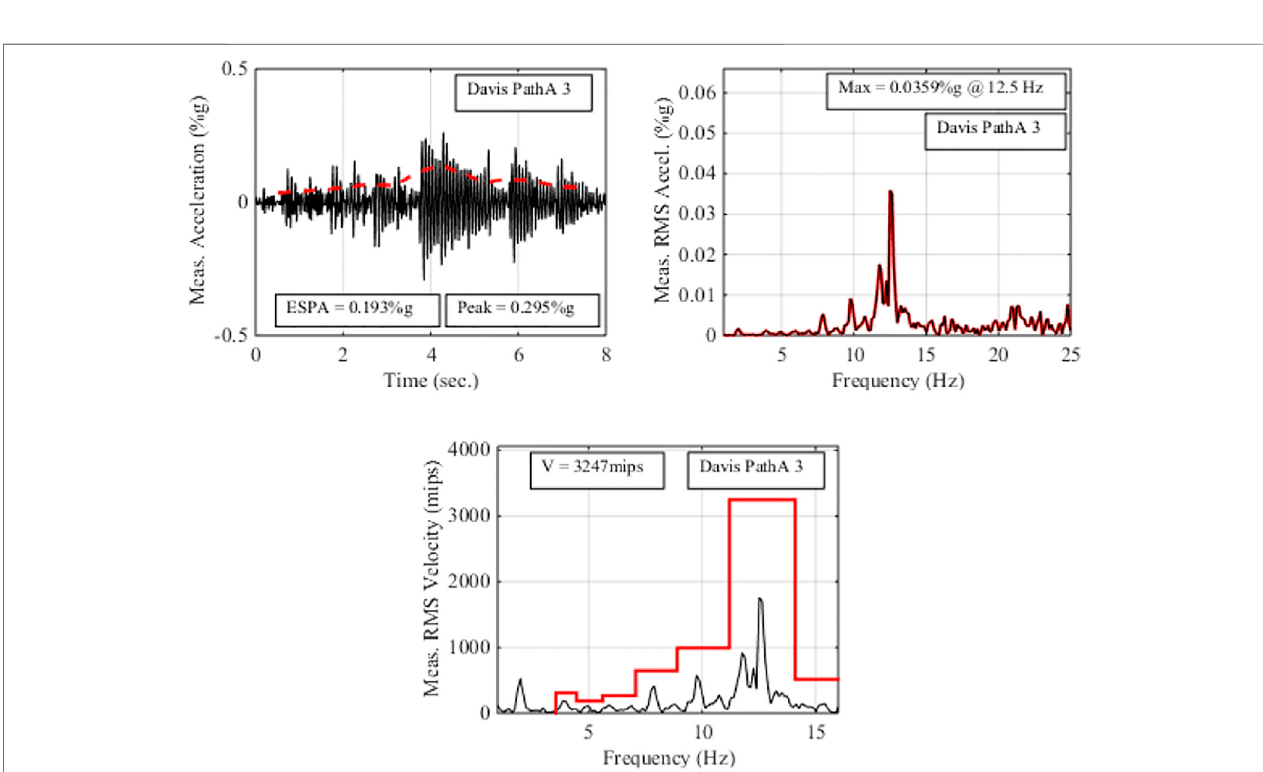
FIGURE 6 | Example walking test results — bare slab con fi guration.